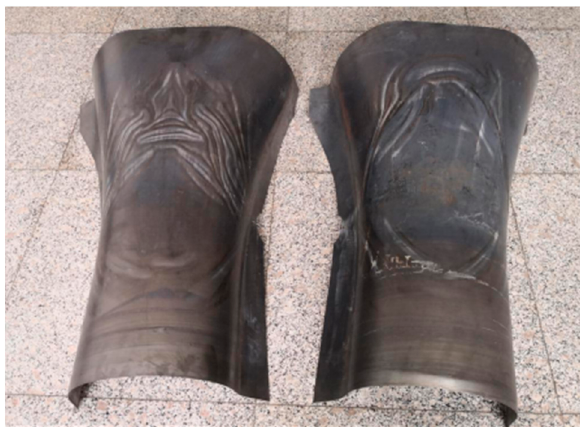
Figure 10. The wrinkle defects of the hot formed part using one-step forming scheme.